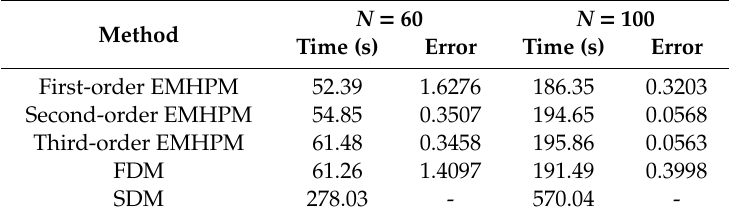
Table 1. Comparison of convergence for di ff erent methods for down-milling operation with a d =